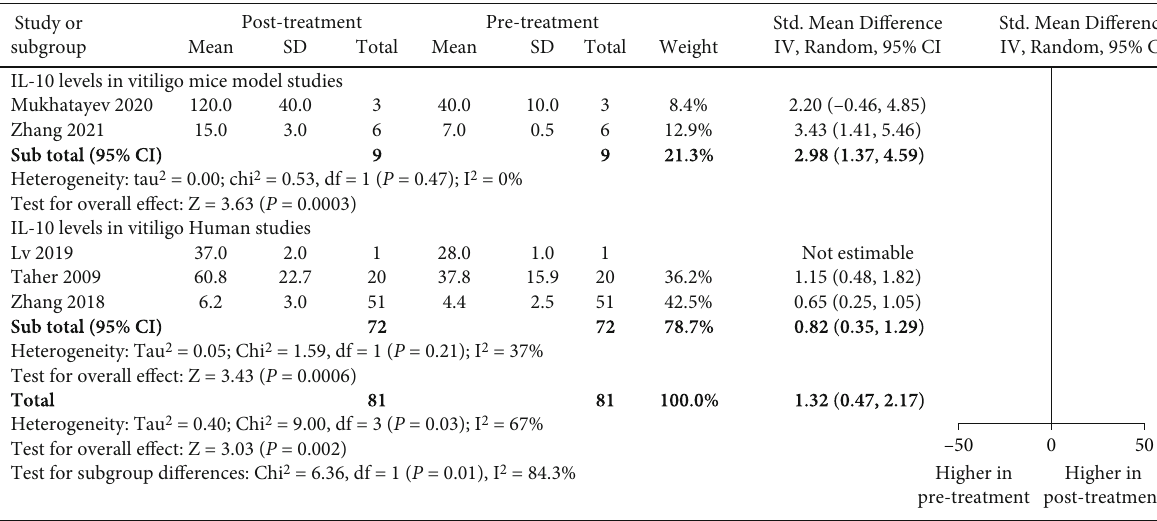
Figure 5: The forest plots for Tregs ’ frequency, FOXP3, and IL-10 levels in vitiligo pre- and posttreatment. (a) Tregs ’ frequency posttreatment vs. pretreatment ( p = 0 : 007 , SMD: 1.64 [0.45, 2.83]). Tregs ’ frequency posttreatment vs. pretreatment in mouse models of vitiligo ( p = 0 : 01 , SMD: 2.11 [0.43, 3.78]). Tregs ’ frequency post treatment vs. pretreatment in human studies for vitiligo ( p = 0 : 21 SMD: 1.16 [-0.65, 2.96]). (b) FOXP3 protein levels posttreatment vs. pretreatment ( p < 0 : 0001 , SMD: 3.43 [1.90, 4.96]). FOXP3 protein levels posttreatment vs. pretreatment in vitiligo mice model study ( p = 0 : 0008 , SMD: 3.43 [1.44, 5.43]). FOXP3 protein levels posttreatment vs. pretreatment in human studies ( p = 0 : 003 , 3.34 [1.13, 5.54]). (c) IL-10 levels posttreatment vs. pretreatment in vitiligo patients ( p = 0 : 002 , SMD: 1.32 [0.47, 2.17]). IL-10 levels posttreatments vs. pretreatment in vitiligo mice models study ( p = 0 : 0003 , SMD: 2.98 [1.37, 4.59]). IL-10 levels post treatment vs. pretreatment in vitiligo human studies ( p = 0 : 0006 , 0.82 [0.35,